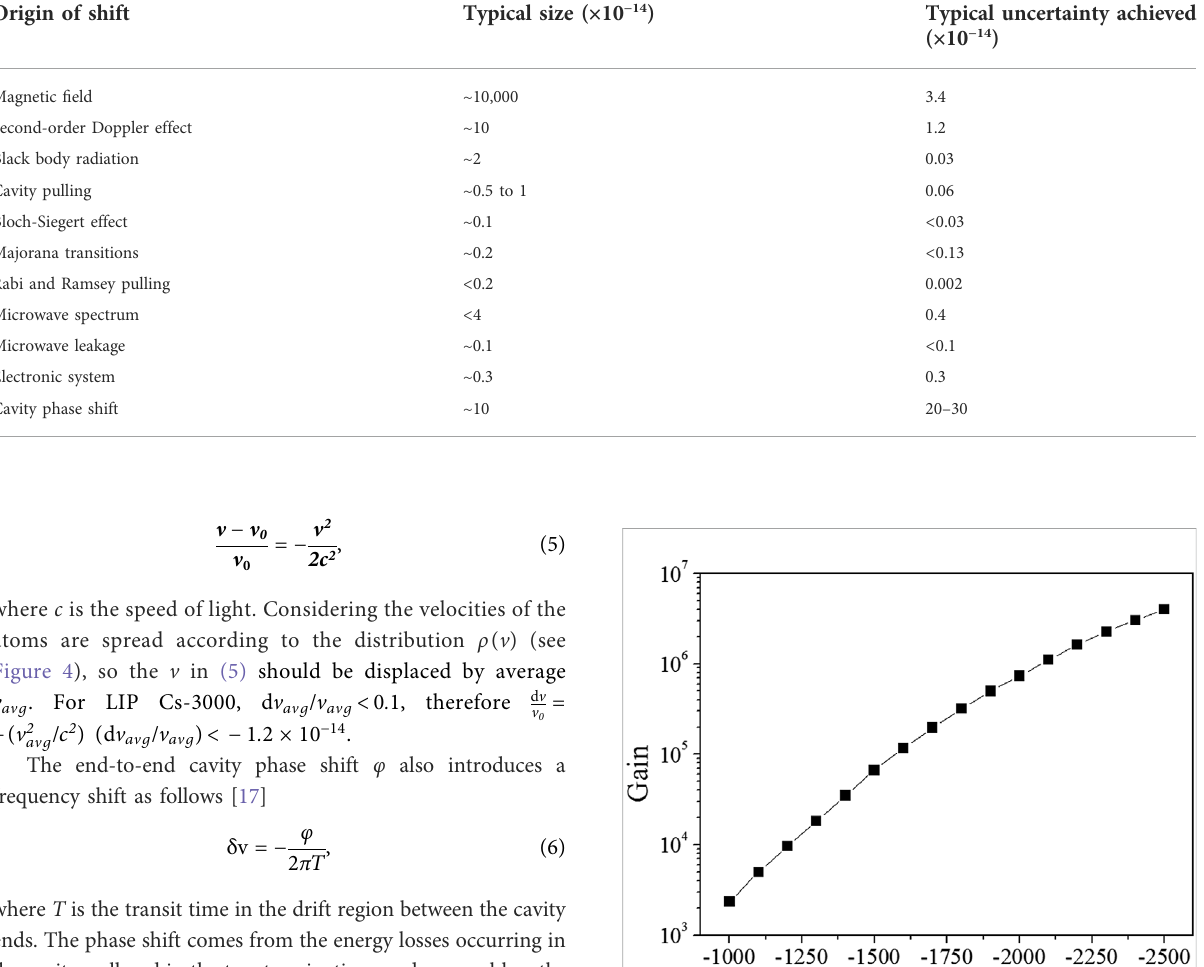
TABLE 1 Summary of frequency shifts and their uncertainties in LIP Cs-3000.